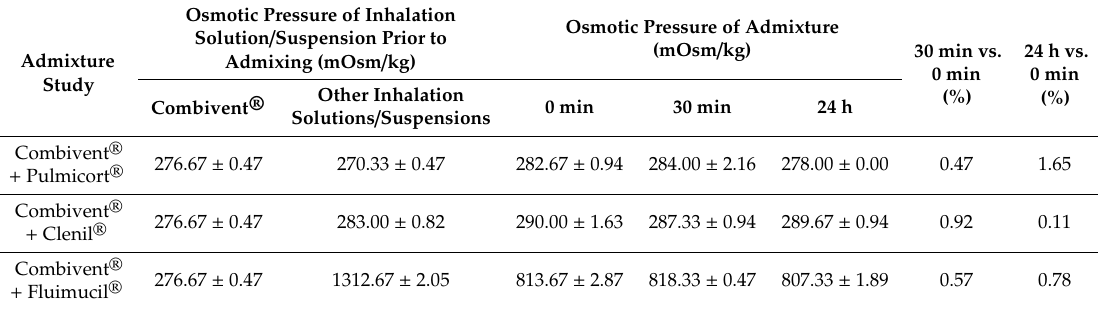
Table 4. Change percentage of the osmotic pressure due to inhalation solution / suspension admixtures at di ff erent time points.